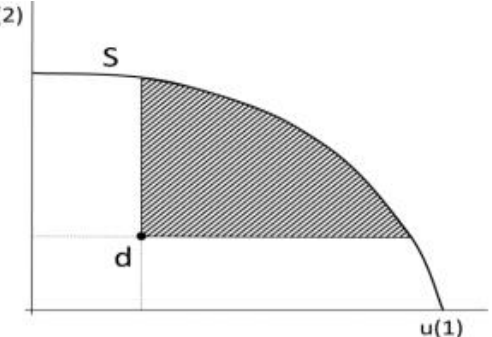
Figure 1. Negotiation as a Nash’s bargaining problem.